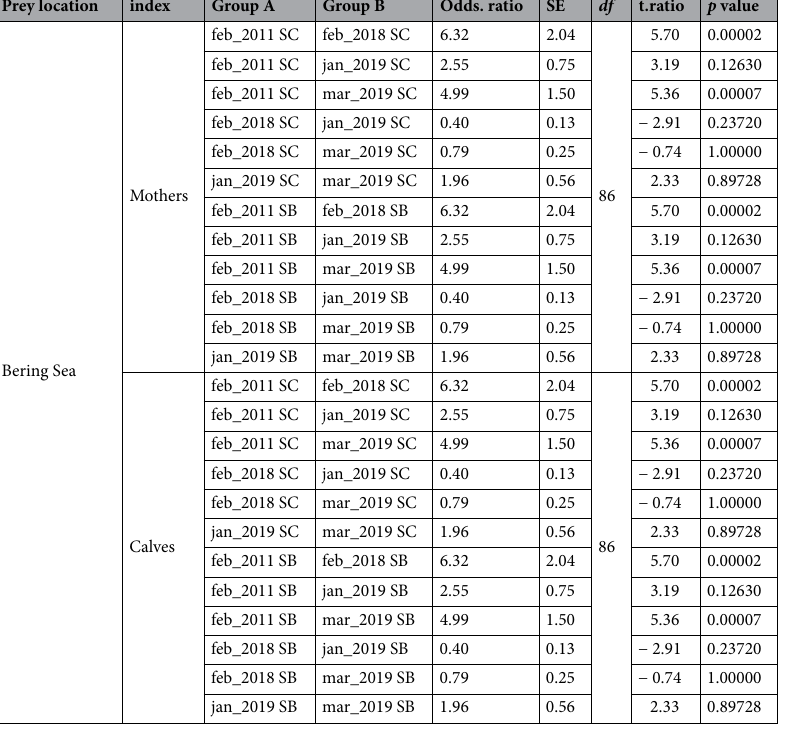
Table 1. Post-hoc analysis results for general linear mixed effect model predictions for Bering Sea amphipods contribution based on “layer” (SC, SB) within each “age” (mothers; calves) and between “year and month” of